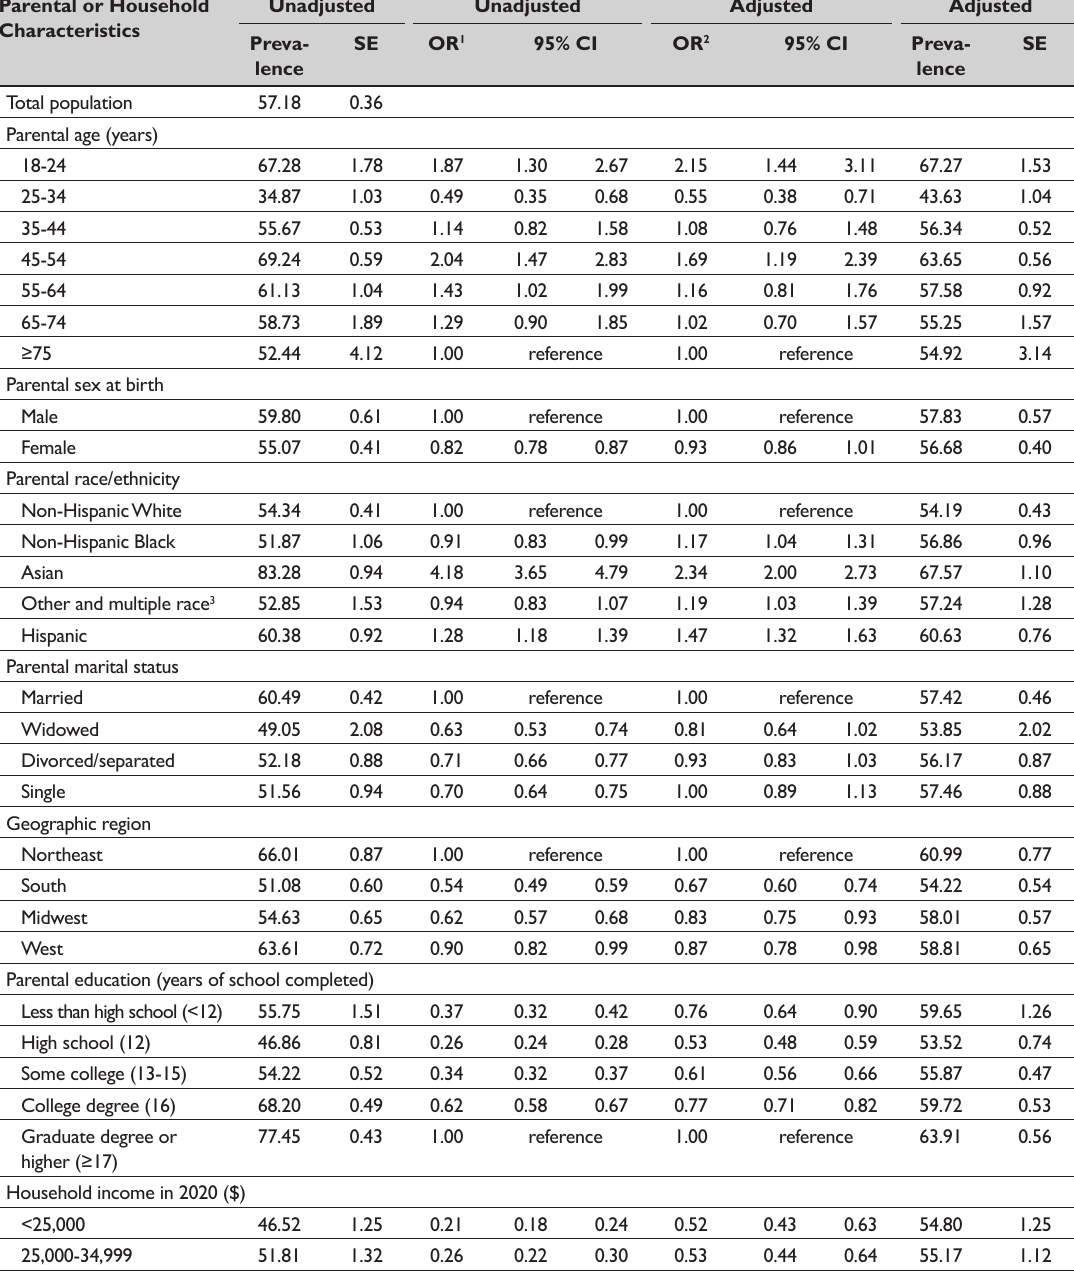
Table 1: Unadjusted and adjusted weighted prevalence (%) and odds of COVID-19 vaccination among US children aged 5-17 years by parental or household socioeconomic and demographic characteristics: The Household Pulse Survey, weeks 40 to 44, December 2021 - April 2022 (N =